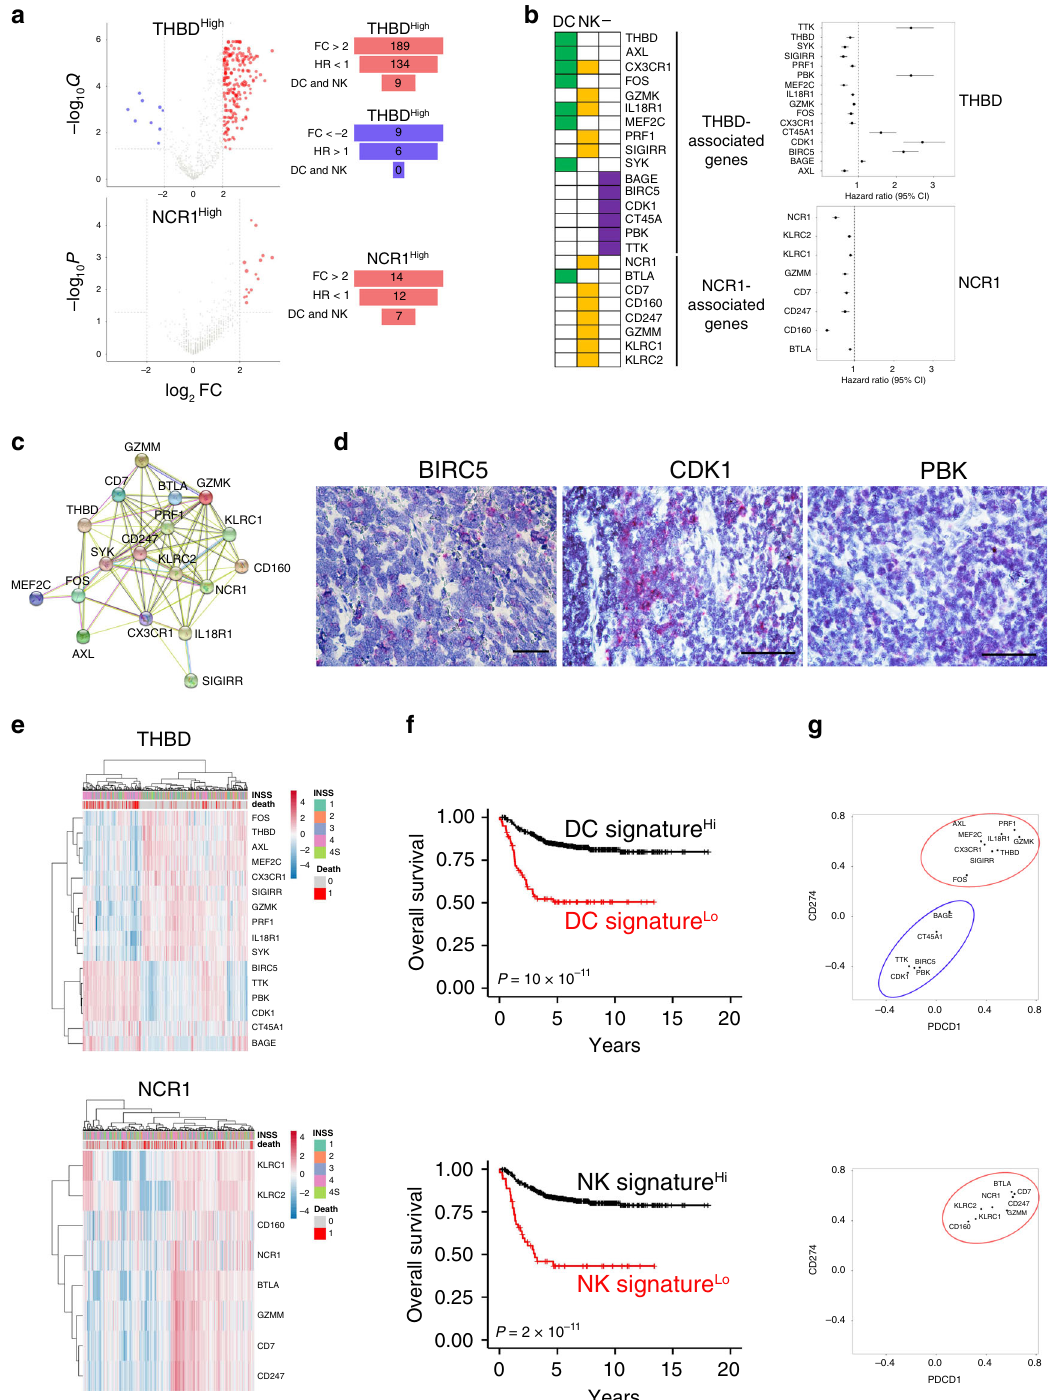
Methods Patients and samples . Tumor samples from 104 NB patients diagnosed between 2002 and 2017 at the Bambino Gesù Children ’ s Hospital (Rome, Italy) were used. All samples were collected at diagnosis and prior to any therapy. For each patient, written informed parental consent was in accordance with the Declaration of Helsinki. The study was approved by the Ethical Committee of the Institution. Clinical pathological details of each sample are shown in Supplementary Table 1. Diagnosis and histology de fi nition were performed according to the International Neuroblastoma Risk Group (INRG) and the International Neuroblastoma Pathology Classi fi cation (INPC) 67,68 , respectively. MYCN and 1p status were evaluated following current guidelines 69 . Patients were treated according to pro- tocols active for the different risk groups 70 – 73 .